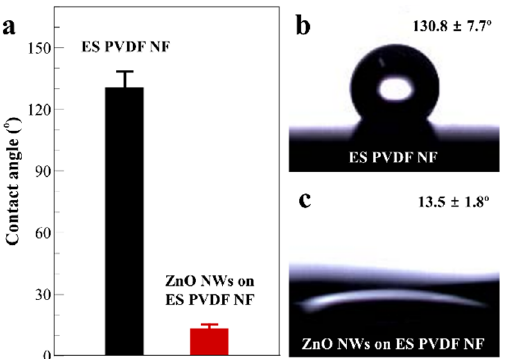
Figure 4. ( a ) The static contact angle measurement and analysis on the film surface of ( b ) an PVDF